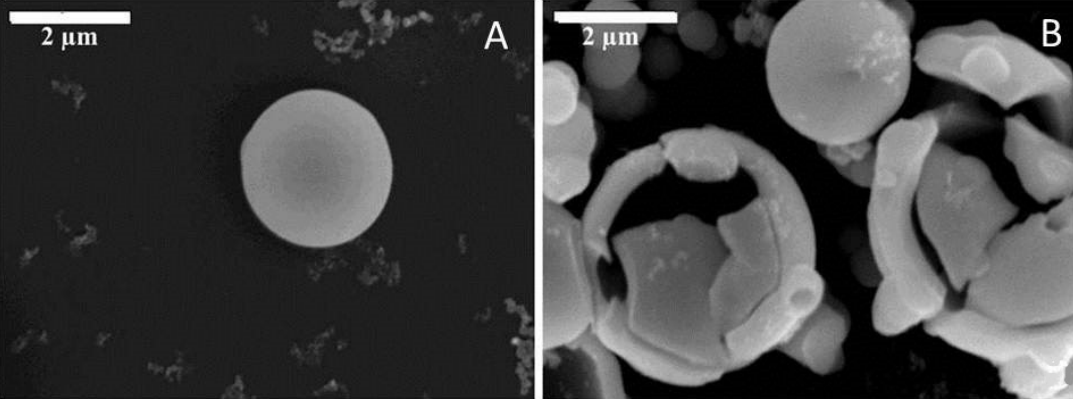
Figure 4. Scanning electron microscopy (SEM) images of intact and intentionally fractured CaCO 3 -coated emulsion microcapsules. ( A ) The core-shell microcapsules consist of a smooth and continuous crystalline CaCO 3 coating. ( B ) Intentionally fractured microcapsules show a relatively thick continuous shell with a hollow interior where the liquid resided. The shell thickness was consistently ~500 nm using this procedure.